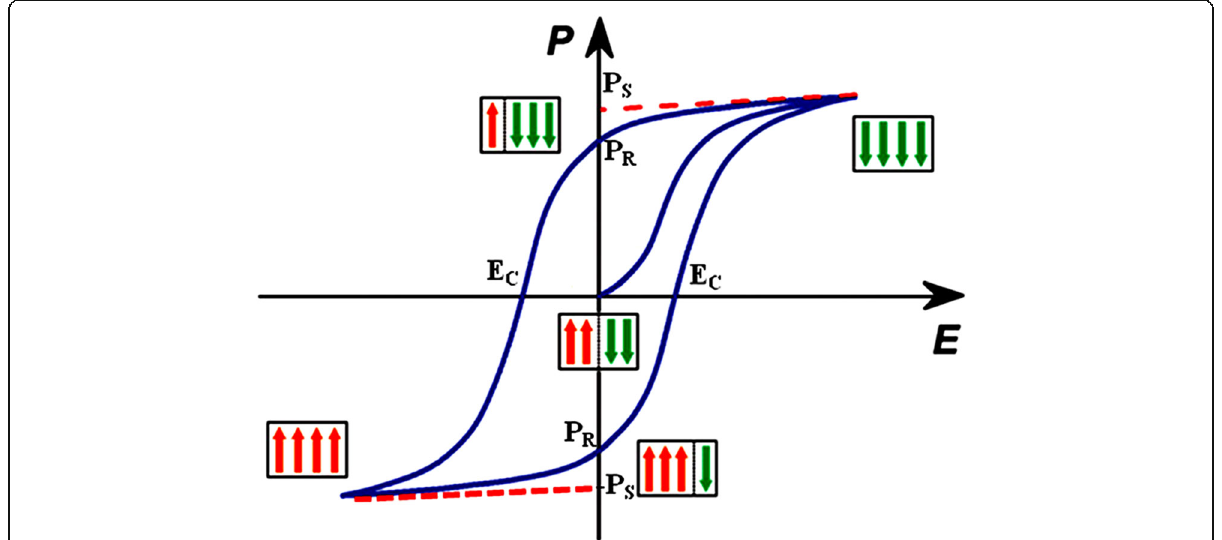
Fig. 2 Hysteresis (P-E) curve in ferroelectric materials